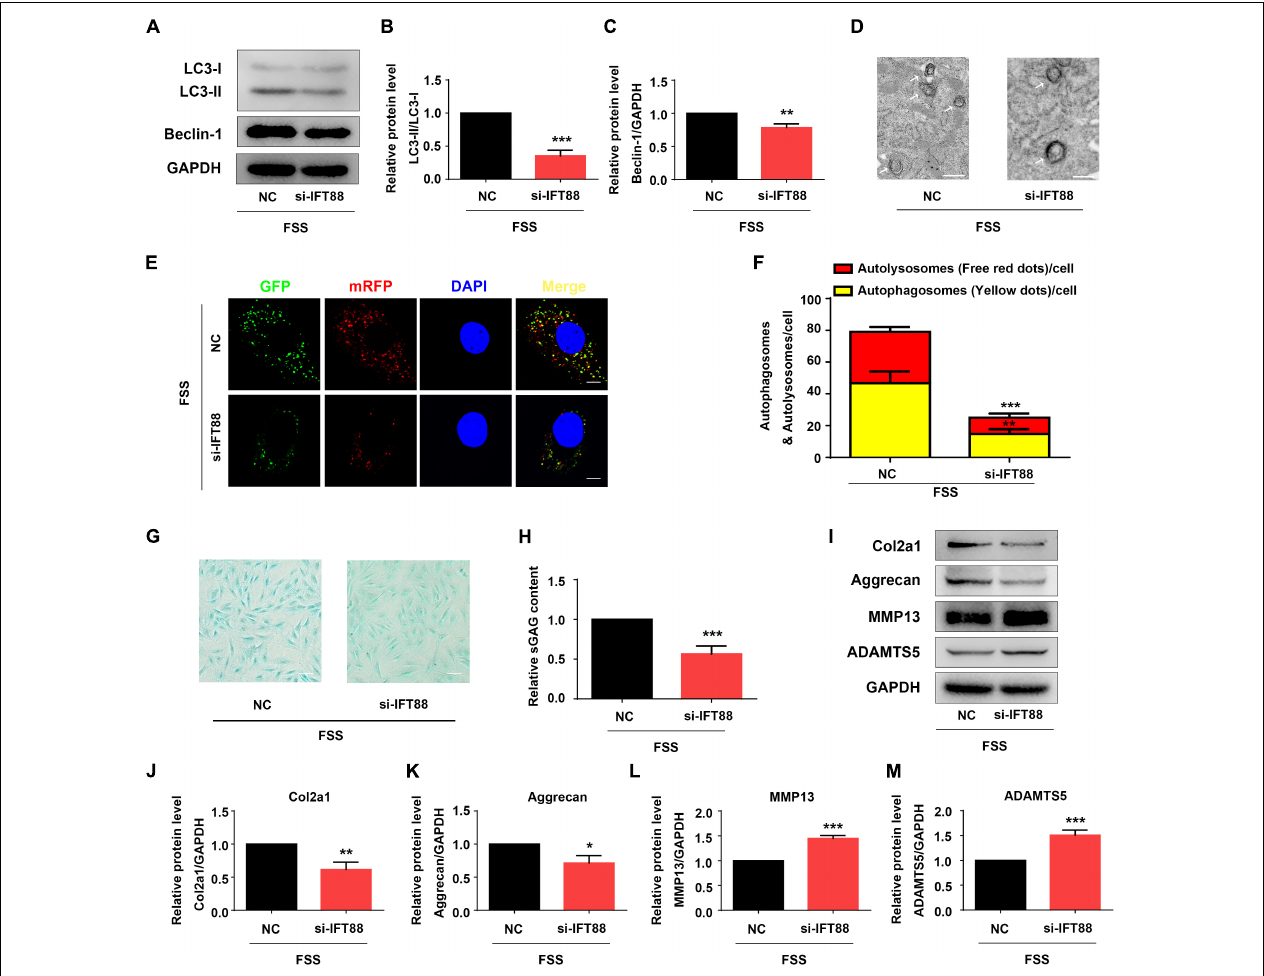
FIGURE 6 | IFT88 loss reduces autophagy and impairs ECM homeostasis in FSS-treated NP cells. (A–C) Western blotting. NP cells were transfected with negative control siRNA (NC-siRNA) or IFT88-siRNA (#1). Then, cells were subjected to 12 dyne/cm 2 FSS for 2 h, followed by western blotting for expression of LC3-I, LC3-II, and Beclin-1 (A) . Quantification of LC3-I/LC3-II ratio and Beclin-1 from three independent experiments (B,C) . (D) Transmission Electron Microscopy (TEM). NP cells were treated as in PANEL (A) . TEM images are shown. The arrows indicate double-membrane autophagosomes and autolysosomes. Bar, 500 nm. (E,F) Measurements of autophagosomes and autolysosomes. NP cells were transduced with lentivirus expressing a tandem mRFP-GFP-LC3 construct and treated as in panel (A) . Fluorescence images were obtained. Bar, 5 µ m. Quantification of autophagosomes (yellow dots) and autolysosomes (free red dots) from three independent experiments (F) . (G,H) sGAG content. NP cells were treated as in panel (A) , followed by alcian blue staining (G) and Blyscan Sulfated Glycosaminoglycan Assay (H) . Bar, 100 µ m. (I–M) Western blotting. NP cells were treated as in panel (A) , followed by western blotting for expression of the indicated proteins (I) . Quantification of expression of Col2a1, aggrecan, MMP13 and ADAMTS5 from three independent experiments (J–M) . Results are expressed as mean ± standard deviation (s.d.). * P < 0.05, ** P < 0.01, and *** P < 0.001 vs. FSS + NC-siRNA